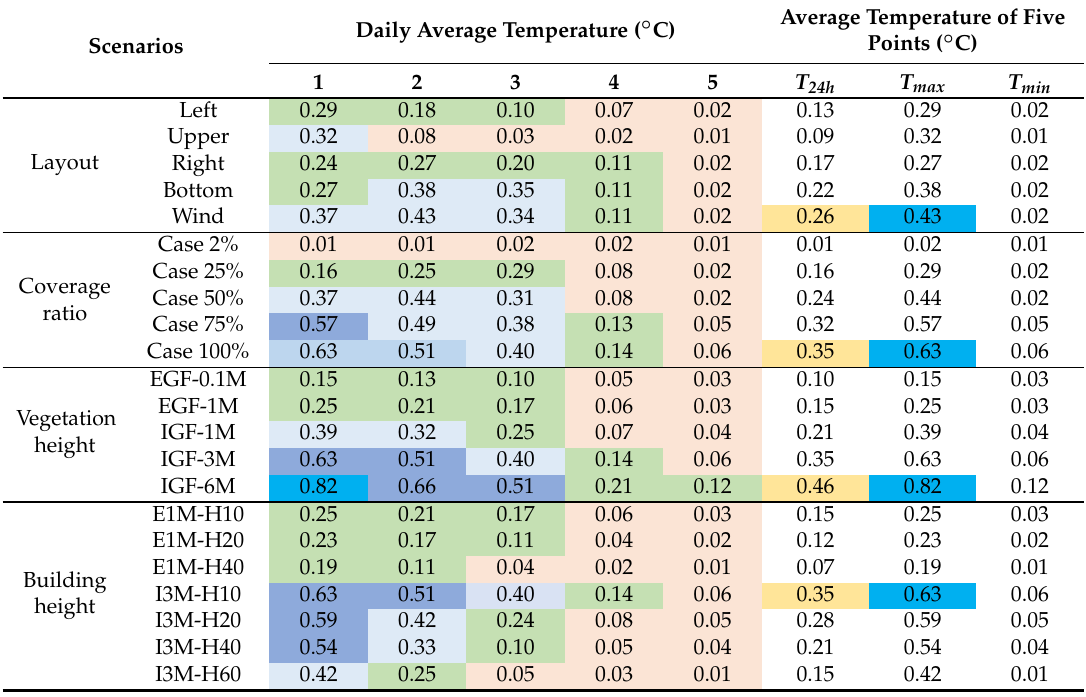
Table 3. A summary of pedestrian cooling performance of green roof in different